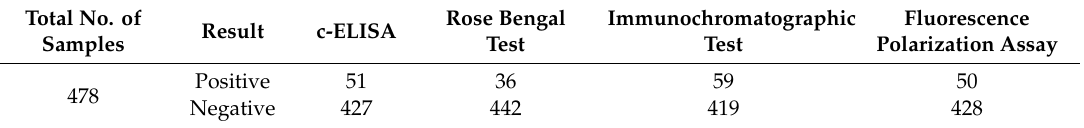
Table 1. Result of testing 478 dromedary camel sera for Brucella antibodies using four serological methods. Total No. of